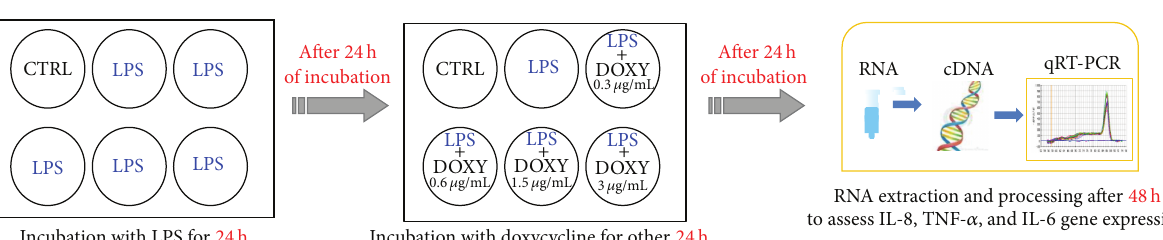
Figure 1: Study design. Schematic representation of the experimental settings with lipopolysaccharide (LPS) (25 𝜇 g/mL) stimulation and doxycycline (DOXY) (0.3, 0.6, 1.5, and 3 mg/ 𝜇 L) incubation. Times of stimulation with substances are described in detail in Section